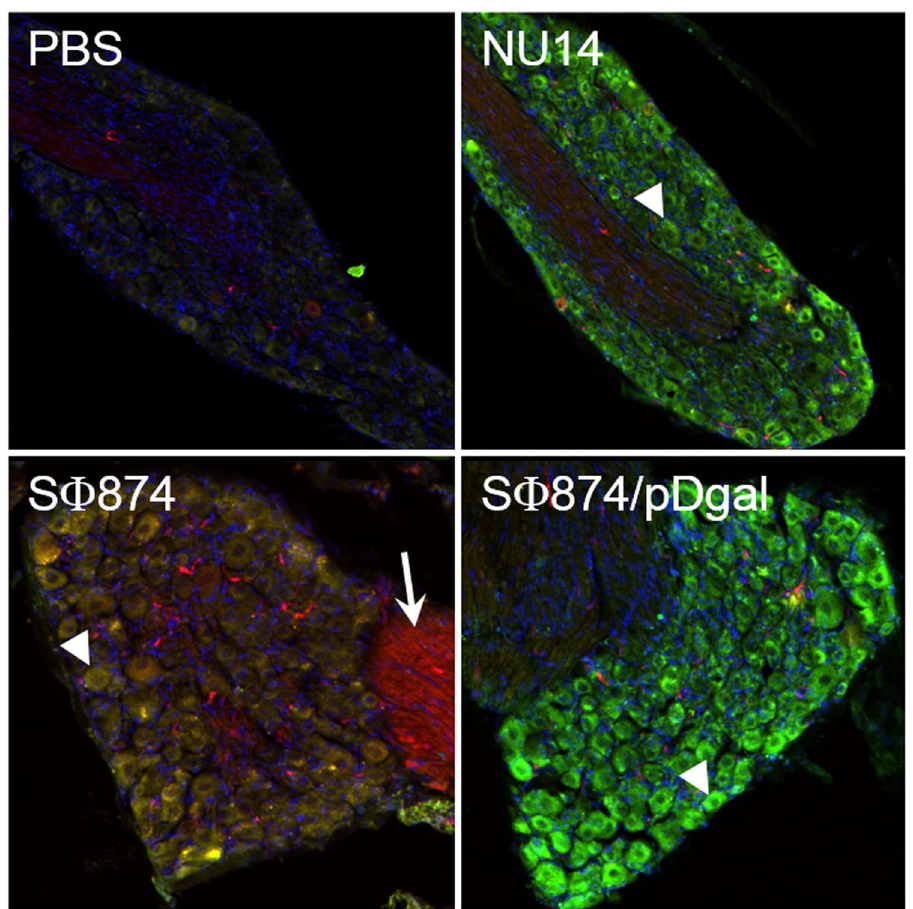
Figure 4. Post-UTI chronic pain is associated with MCP1 induction. MCP-RFP/CCR2-GFP mice were instilled with PBS or infected with E. coli strain NU14, S Φ 874 or S Φ 874/pDgal. Isolated sacral DRGs of saline-instilled mice have low RFP and GFP expression. GFP expression was marked in DRG cell bodies of mice infected with either NU14 or S Φ 874/pDgal (arrowheads). DRGs of S Φ 874-infected mice expressed RFP in fibers (arrow) colocalized with neuronal cell bodies expressing GFP (yellow,